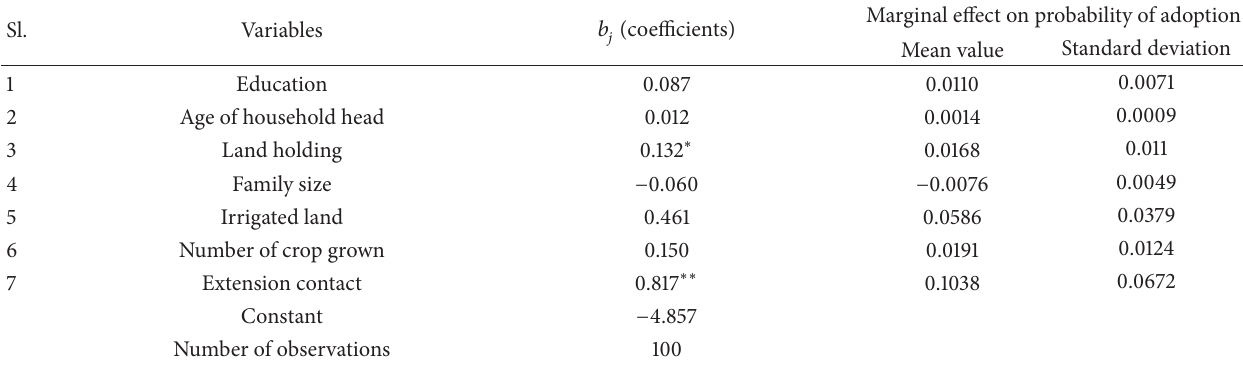
Table 6: Logit model for farmers’ decision on adoption of seed production technology.